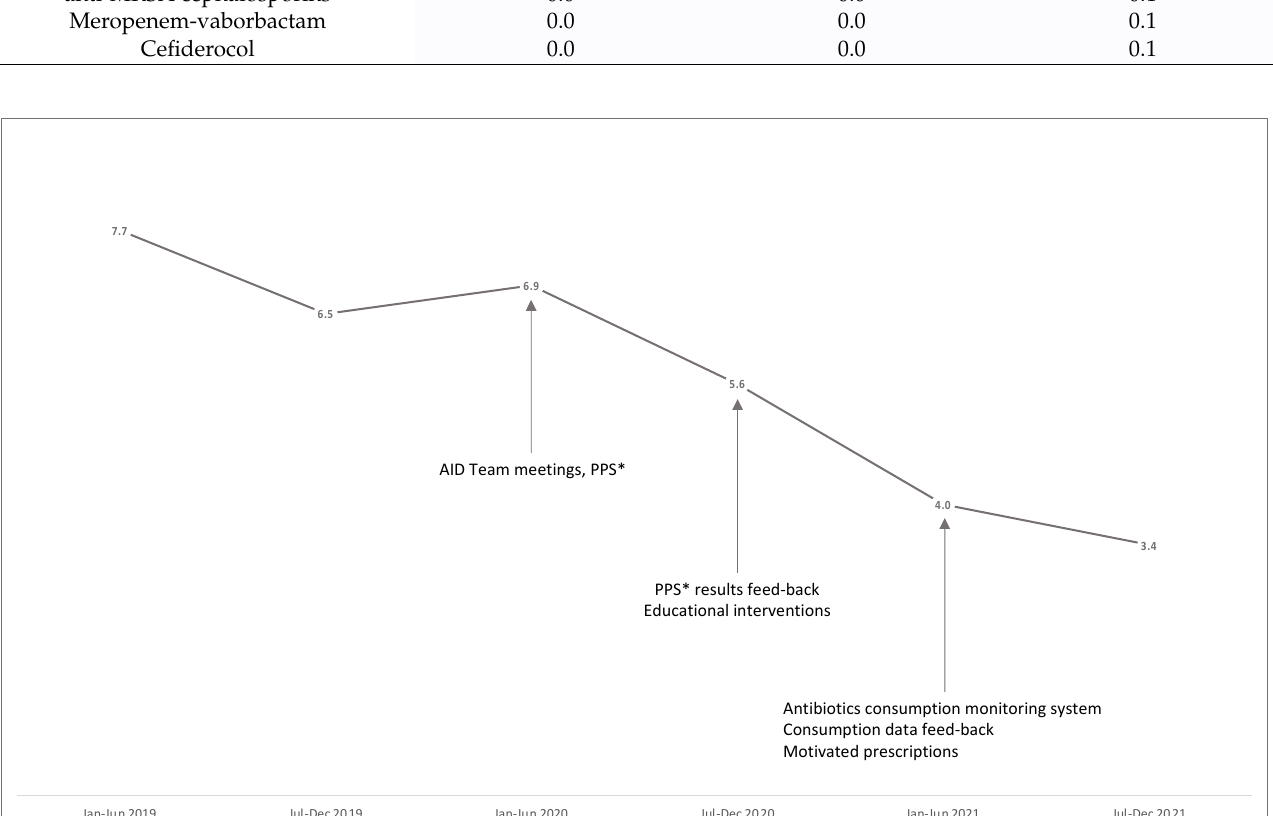
Figure 1. Evolution over time of FQs consumption (DDD/100 bd); * Point Prevalence Survey of healthcare-associated infections and antimicrobial use.